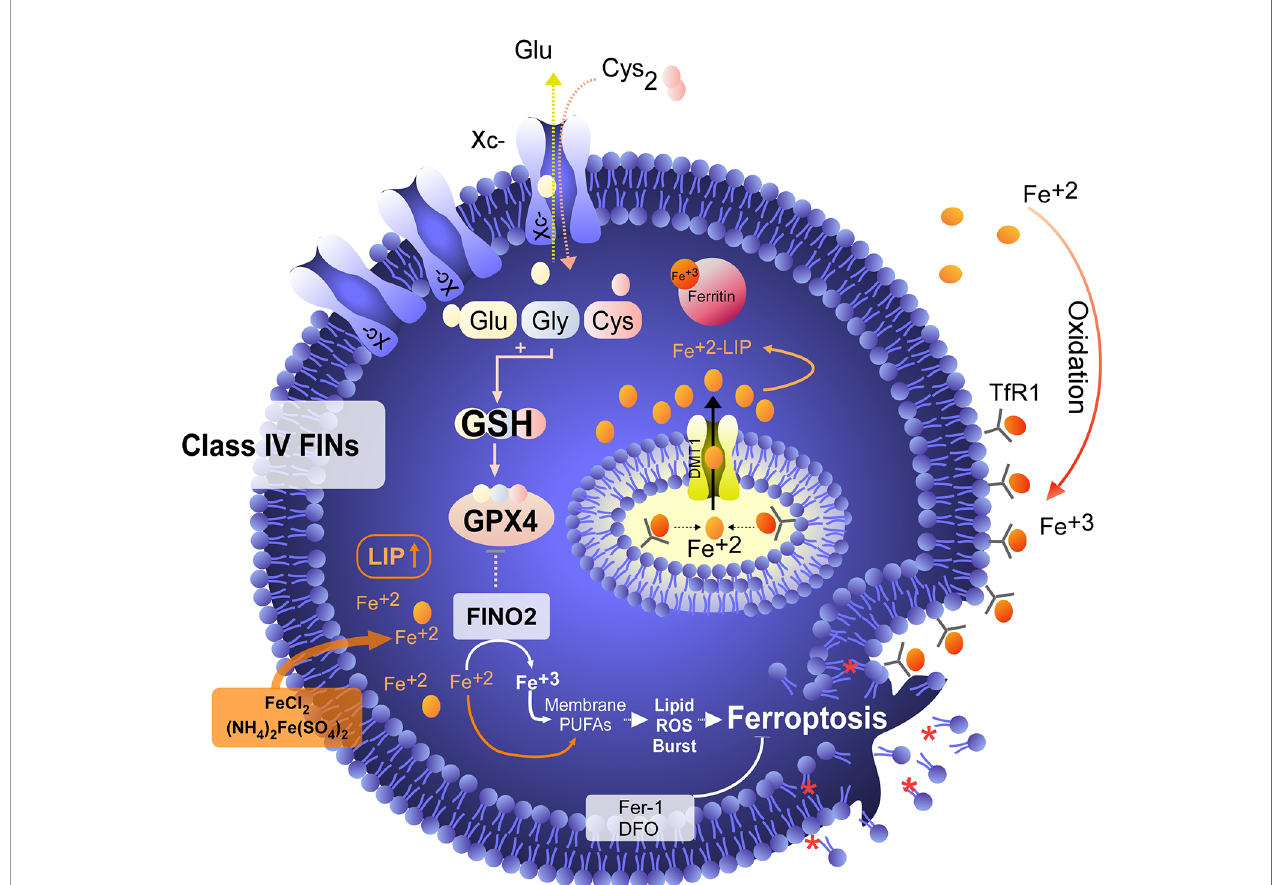
FIGURE 5 | Iron overload or peroxidation induces ferroptosis in tumor cells. Class IV FINs are ferroptosis inducers that directly involve metabolism and iron levels in the cell. On the one hand, we have found synthetic molecules, such as FINO 2 , that alter the metabolism of iron, favoring its intracellular oxidation. In addition to promoting the oxidation of iron, FINO 2 indirectly inhibits the activity of GPX4. On the other hand, when the labile iron pool (LIP) is increased by exogenous treatment with iron or iron nanoparticles, an overload of this metal is generated, which induces lipid peroxidation without the need for GPX4 inhibition. Class IV FINs are fairly attractive agents for the induction offerroptosis because tumor cells are addicted to iron due to their low ferroportin (FPN) expression and high levels of transferrin receptor (TfR) expression, which favors an increase in the LIP. In this context, treatment with exogenous iron (e.g., FeCl 2 ) in combination with FINO 2 would eventually be a potent inducer offerroptosis in tumor cells. Unfortunately, the development of FINO 2 analogs for in vivo use is necessary to test whether the increases LIP and iron peroxidation are synergistic to speci fi cally kill tumor cells.